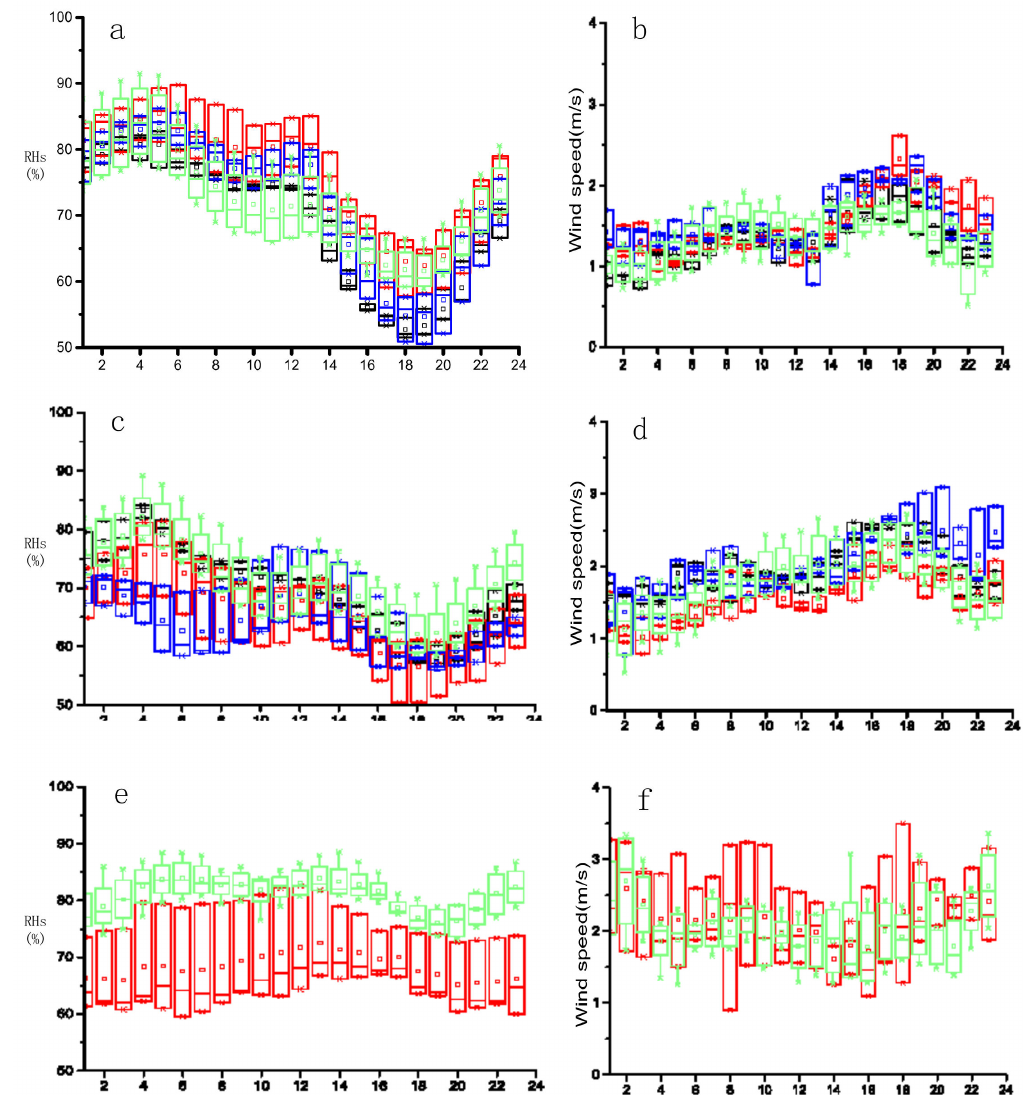
Figure 6. Diurnal variations of wind speed and RHs for EQP( a , b ), ACF( c , d ) and INT( e , f ); red: North Jiangsu, black: South Jiangsu, green: Southwest Jiangsu, blue: Coastal Jiangsu, X-axis was time (unit: h); Rectangle: 25%-75% (quartile); rectangle midline: the median; end of the line: 5%-95%; × : 1% and 99%; (cid:3) : average. (equalized pressure (EQP), advancing edge of a cold front (ACF) and inverted trough of low pressure